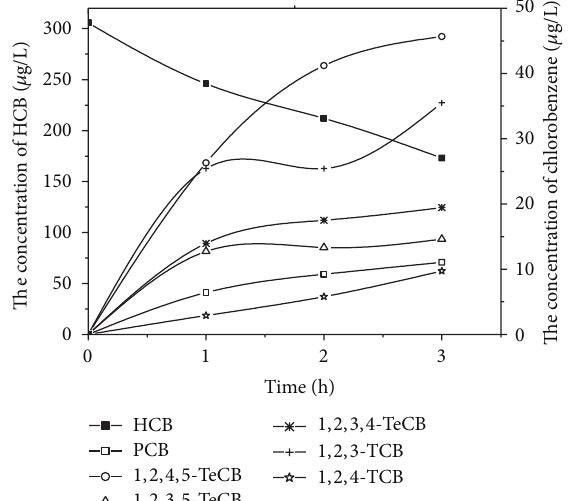
Figure 3: Variation of HCB and its dechlorination intermediates concentration using stainless steel